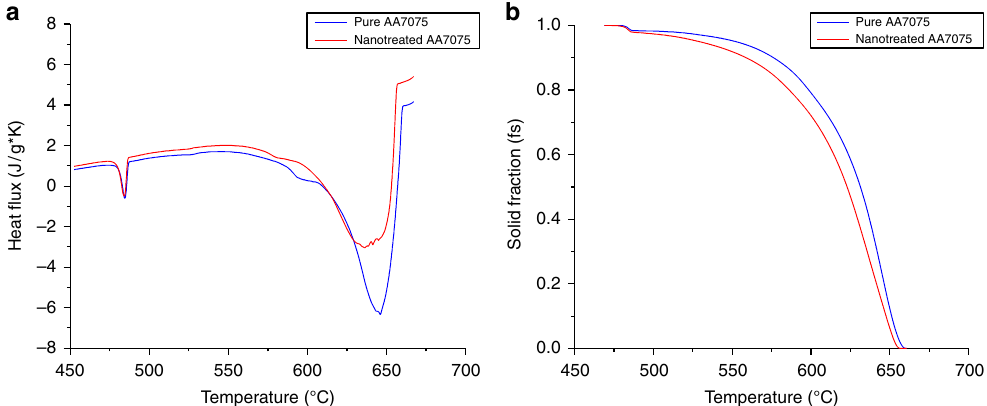
Fig. 4 DSC analyses of pure AA7075 and nano-treated AA7075 melting zones. a DSC cooling curves showing the normalized heat fl ux of melting zone samples taken from joints welded with AA7075 and with nano-treated AA7075 fi ller material. b Solid fraction vs. temperature curves derived from DSC results